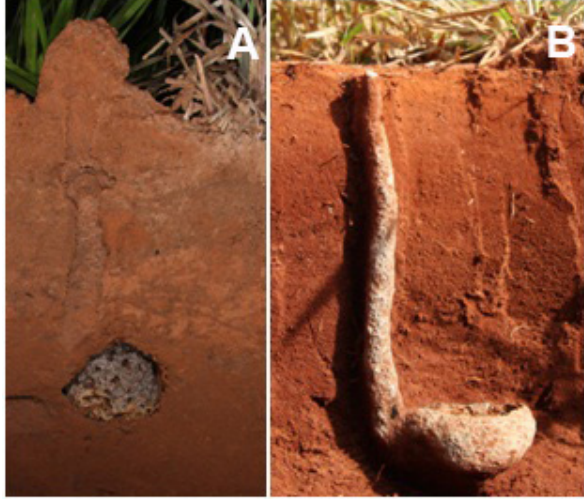
Fig 2. Initial nest of Atta sexdens : A) Excavated at 4 months after nest foundation; B) Initial nest molded with cement at four months after nest foundation.